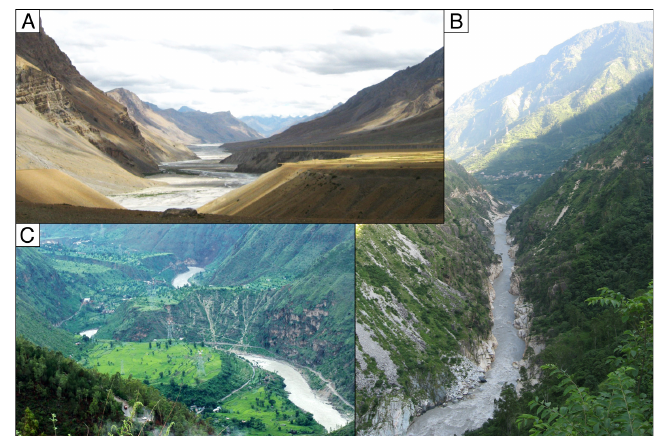
Fig. 11. Images of varying sediment storage in the Sutlej River Valley. (A) Fluvial terrace and alluvial fans along the high-elevated Spiti River, a major tributary to the Sutlej. (B) Incised bedrock along the steep middle Sutlej River section upstream of Rampur (cf. Fig. 1b) at the Himalayan Crest. (C) Extensive fluvial terraces along the moderately inclined lower Sutlej River section downstream of Rampur at the main Himalayan Front (cf. Bookhagen et al., 2006).